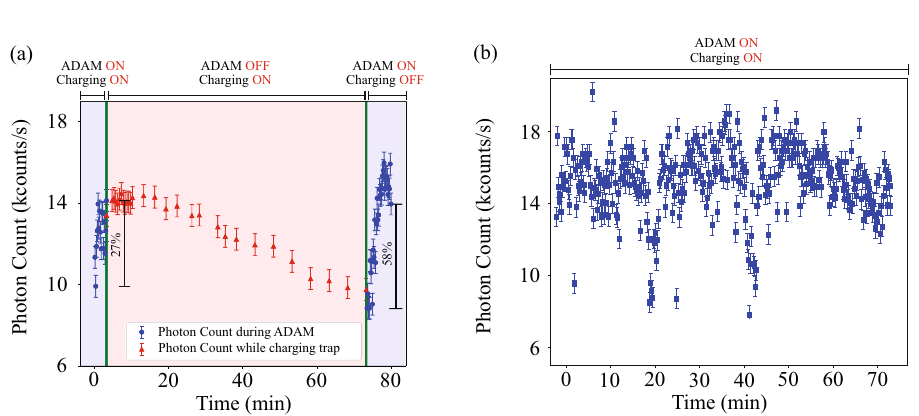
Figure 5. ( a ) Real time compensation with ADAM of laser charging induced stray electric field. The ion was optimized using ADAM (left blue points) then the photon count was noted whilst charging for 70 min (red points) then re-optimized (right blue points). Initial improvement from manually optimized settings was 27%. The second optimization improved the fluorescence by 58% from the charged conditions and returned it back to the optimum value of the first optimization within the error. ( b ) The trap was charged by hitting a UV laser to destabilize the ion and individual electrodes optimized using ADAM simultaneously for 70 min. The photon count fluctuates as a result of combination of fluctuations of power of the cooling laser power, algorithm search and charging irregularities. The optimizer keeps the fluorescence at the photon count similar to the case of optimizing after the charging is stopped (third section of